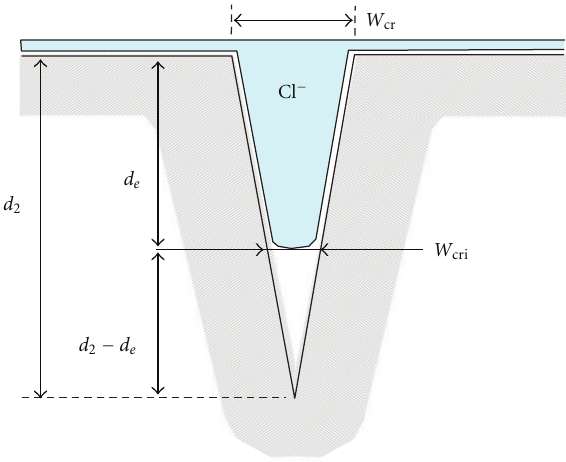
Figure 9: Schematic representation of e ff ective crack depth accord- ing to critical crack